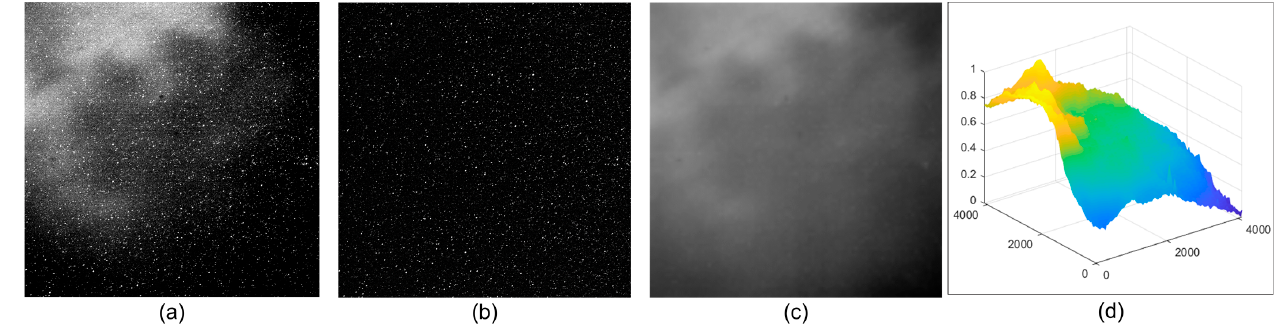
Figure 6. In the case of a fewer number of clouds, our model can still obtain reliable result. ( a ) The captured image with the image acquisition equipment mentioned in Section 2.1; ( b ) the corrected image that the clouds are removed; ( c ) the estimated background by our method; and ( d ) the grey- level distribution of ( c ).